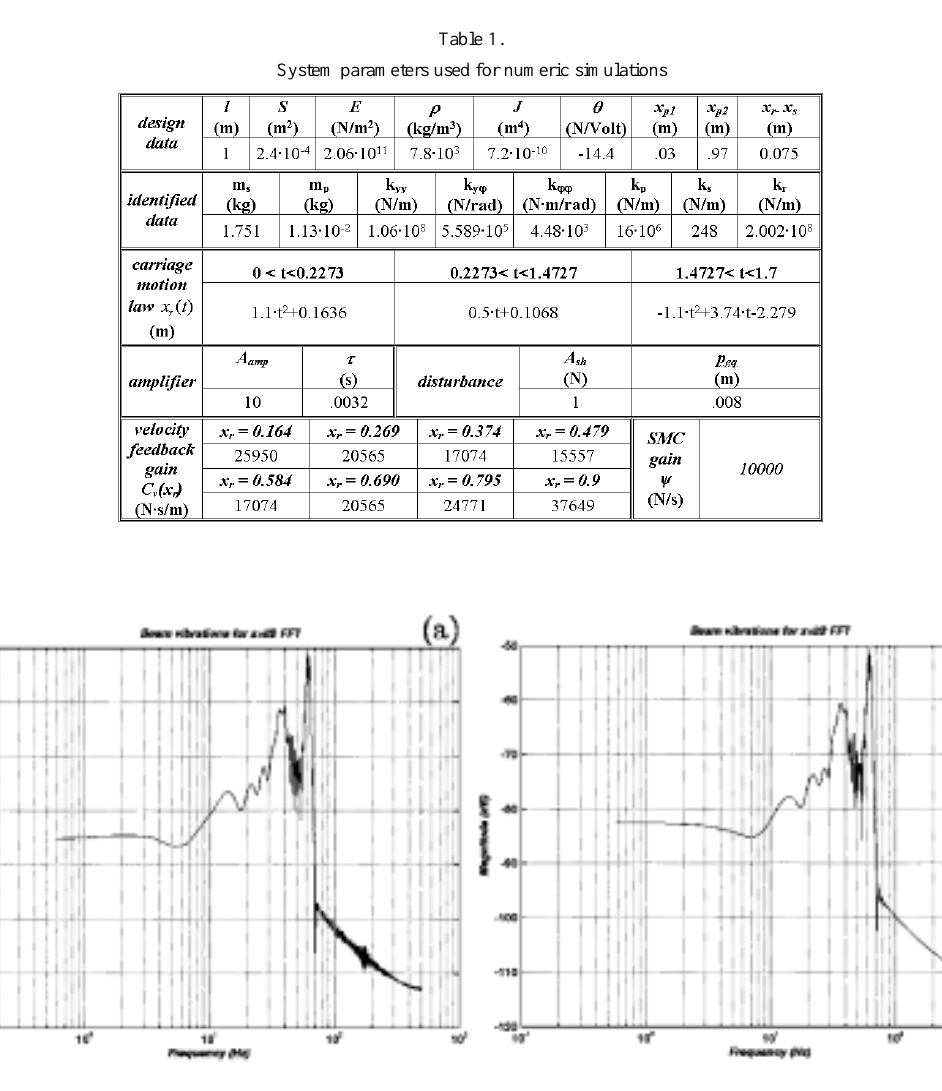
Fig. 5. Frequency spectrum of beam half-point vibrations: a) ‘ideal’ force control, b) SMC force